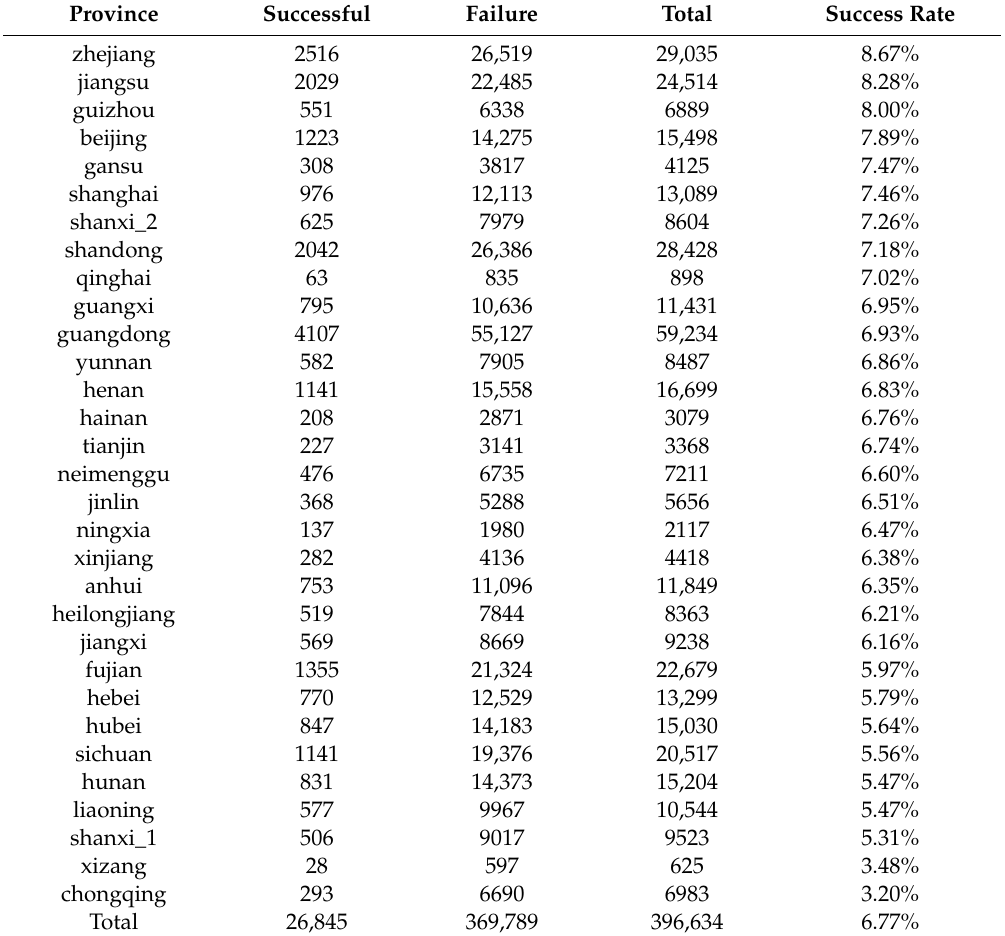
Table 4. Lending success rates in 31 provinces in